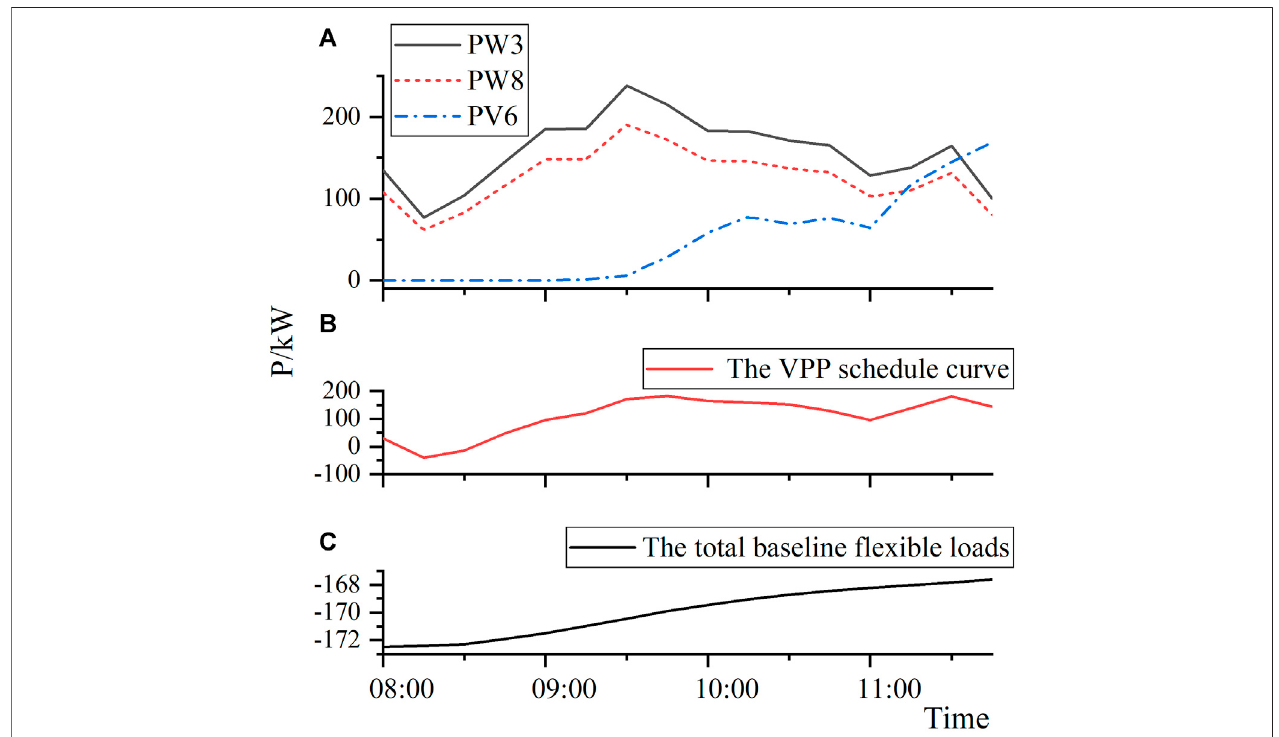
FIGURE 4 | VPP data: (A) The look-ahead forecasting curve (B) The VPP schedule curve (C) The total baseline fl exible loads.